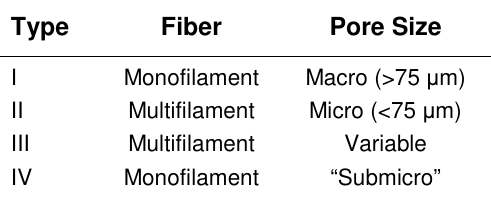
Classification of Mesh